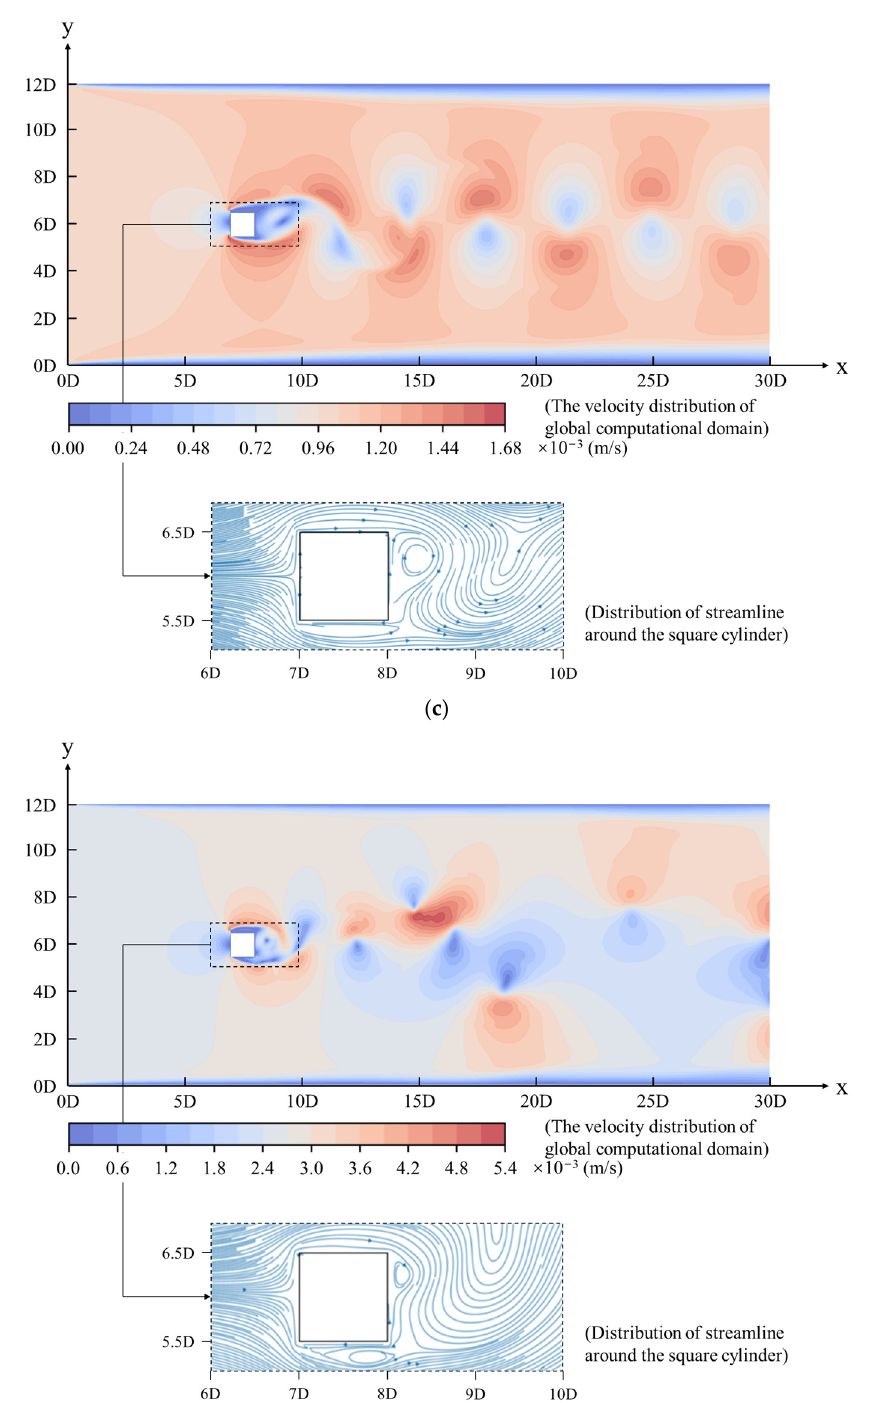
Figure 4. Di ff erent classi fi cations of fl ow distribution around a square cylinder; ( a ) Classi fi cation L1 ( 𝑅 (cid:3032) = 40); ( b ) Classi fi cation L2 ( 𝑅 (cid:3032) = 95); ( c ) Classi fi cation L3 ( 𝑅 (cid:3032) = 400); and ( d ) Classi fi cation T ( 𝑅 (cid:3032) = L1 ( R e = 40); ( b ) Classification L2 ( R e = 95); ( c ) Classification L3 ( R e = 400); and ( d ) Classification T 1000). ( R e =